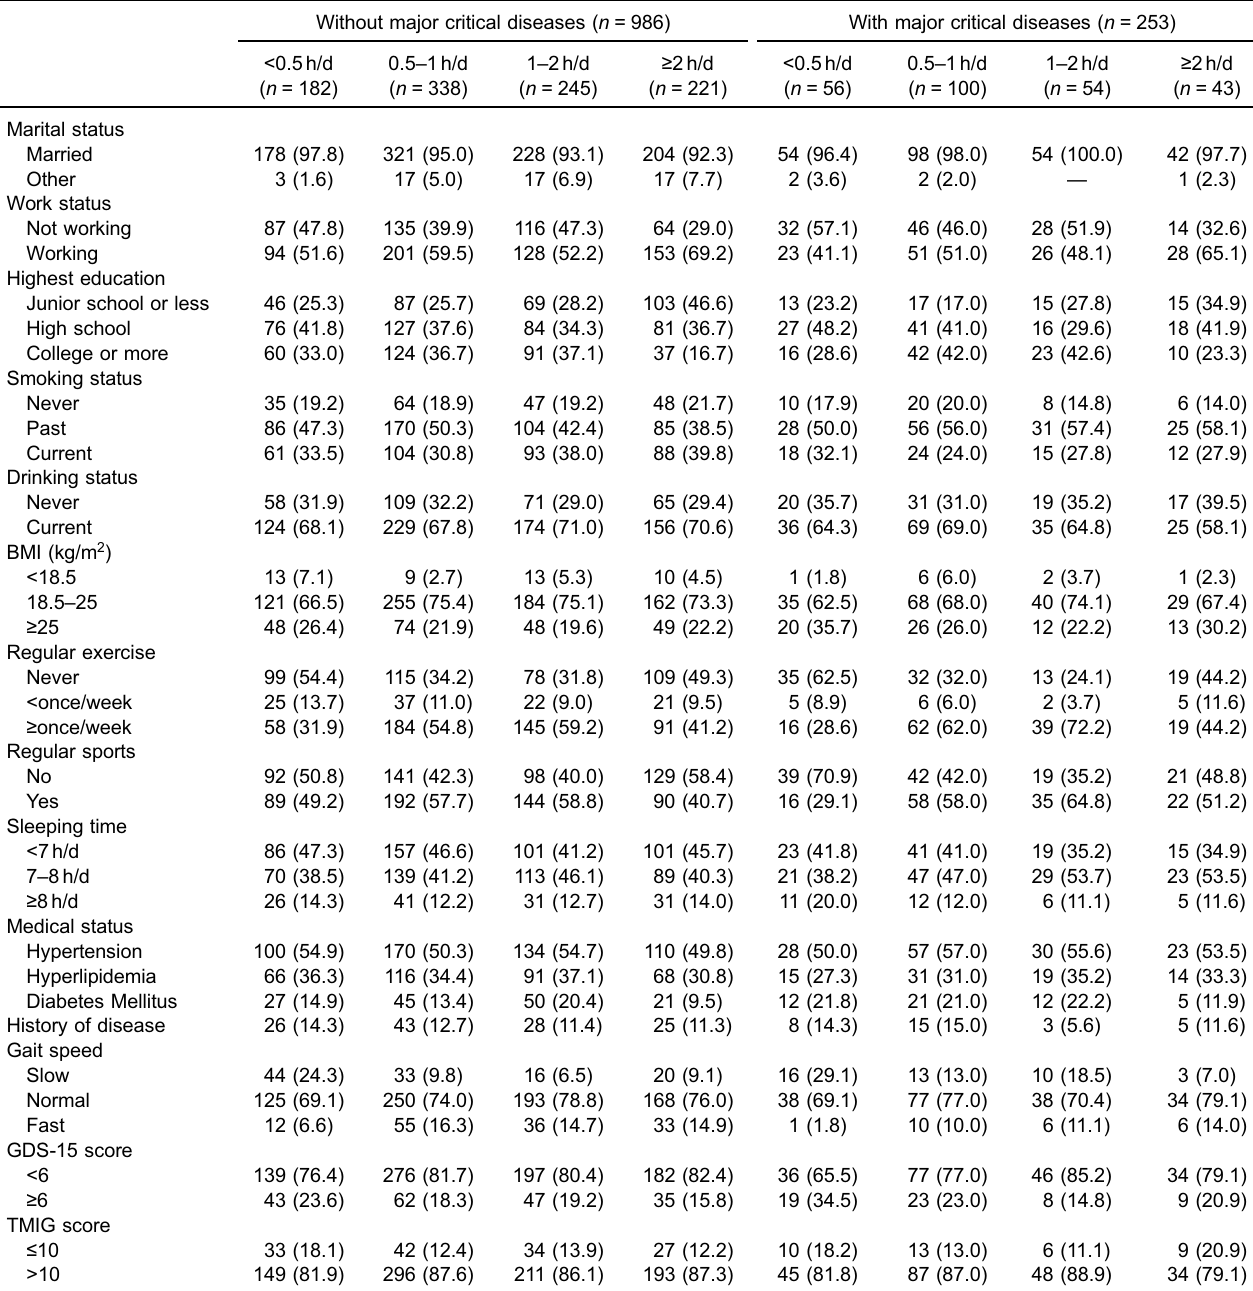
Table 1. Baseline characteristics according to daily walking and morbidity of major critical diseases ( n =